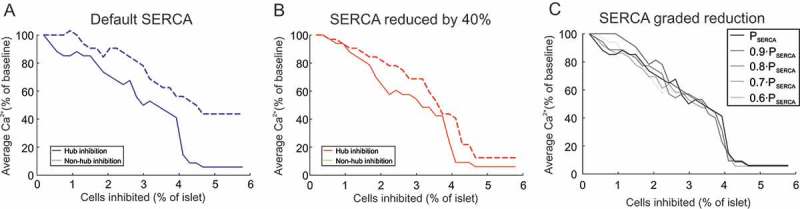
Influence of SERCA on hub importance. (A) Ca2+i activity in a mouse islet model as a function of the number of cells inhibited (% of islet). Either hubs or non-hubs were inhibited, and Ca2+i activity (% of no inhibition) was quantified. The value of PSERCA (the maximum flux of Ca2+ through the SERCA pump) in this model was set to its default value (0.096 amole/ms), according to the Cha-Noma model. (B) Same as in (A) but where PSERCA was reduced by 40%. (C) Same as in (B) but displaying hub inhibition only, with graded reduction in PSERCA.